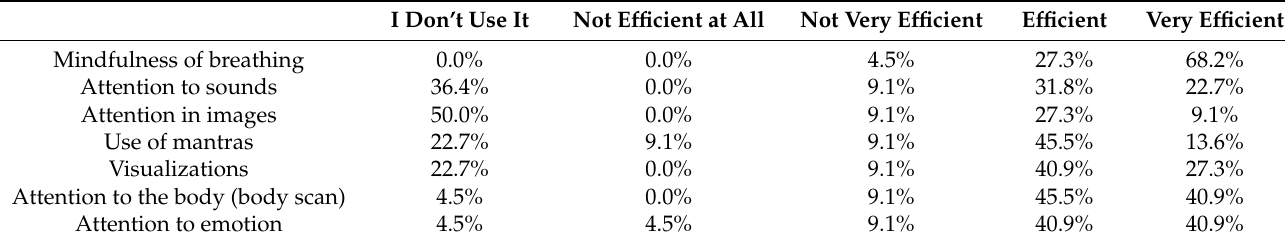
Table 4. Efficacy of the techniques